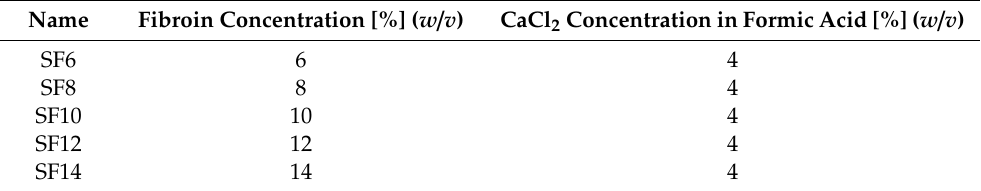
Table 3. Chemical composition of the facilitated fibroin